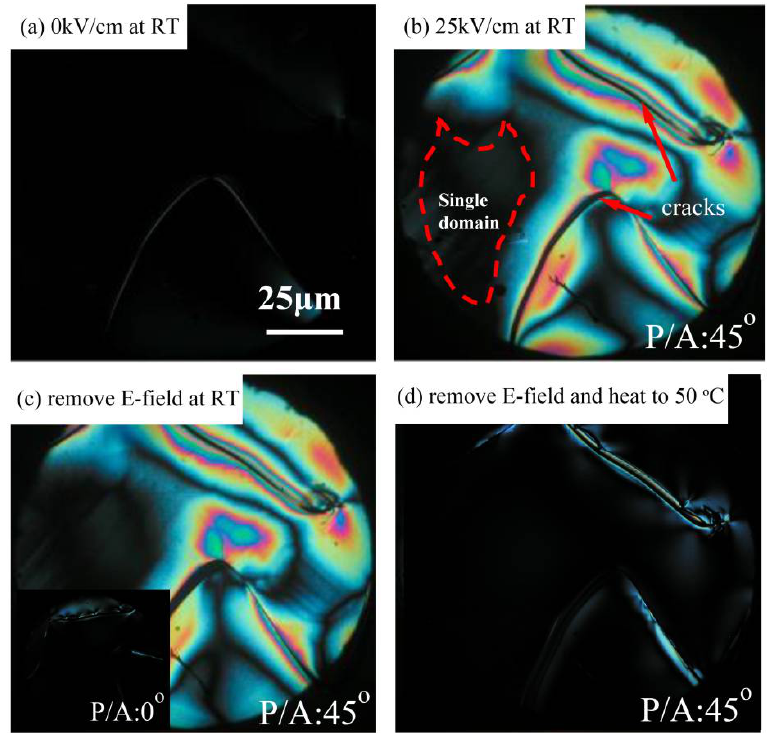
Figure 3. < 001 > oriented domain evolution of NBT-6BT-KNN crystal at the following di ff erent Figure 3. <001> oriented domain evolution of NBT-6BT-KNN crystal at the following different conditions in sequence (a–d): ( a ) initial state, electric field E = 0 kV / cm, at room temperature (RT); conditions in sequence(a–d): ( a ) initial state, electric field E = 0 kV/cm, at room temperature (RT); ( b ) ( b ) positive increase of E to 25 kV / cm at RT; ( c ) remove electric field at RT; ( d ) heating to 50 ◦ C after positive increase of E to 25 kV/cm at RT; ( c ) remove electric field at RT; ( d ) heating to 50 °C after removing electric removing electric field.